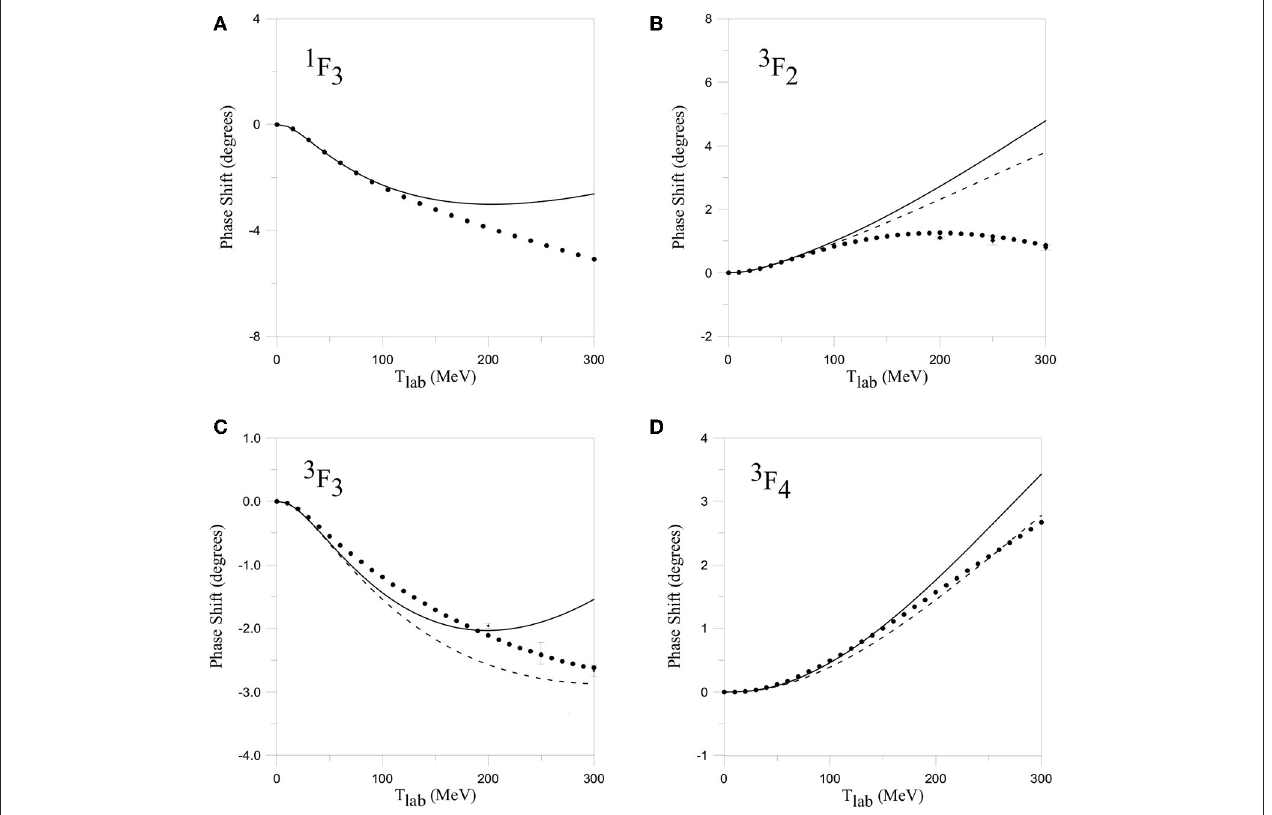
FIGURE 9 | NN F phase-shifts. In the T 0 sector (A) , the solid line includes NN channels only. In the T = NN channels only, and the solid line considers also N 1 channels. Reprinted figure with permission from Entem et al. [ 52] Copyright (2000) by the American Physical